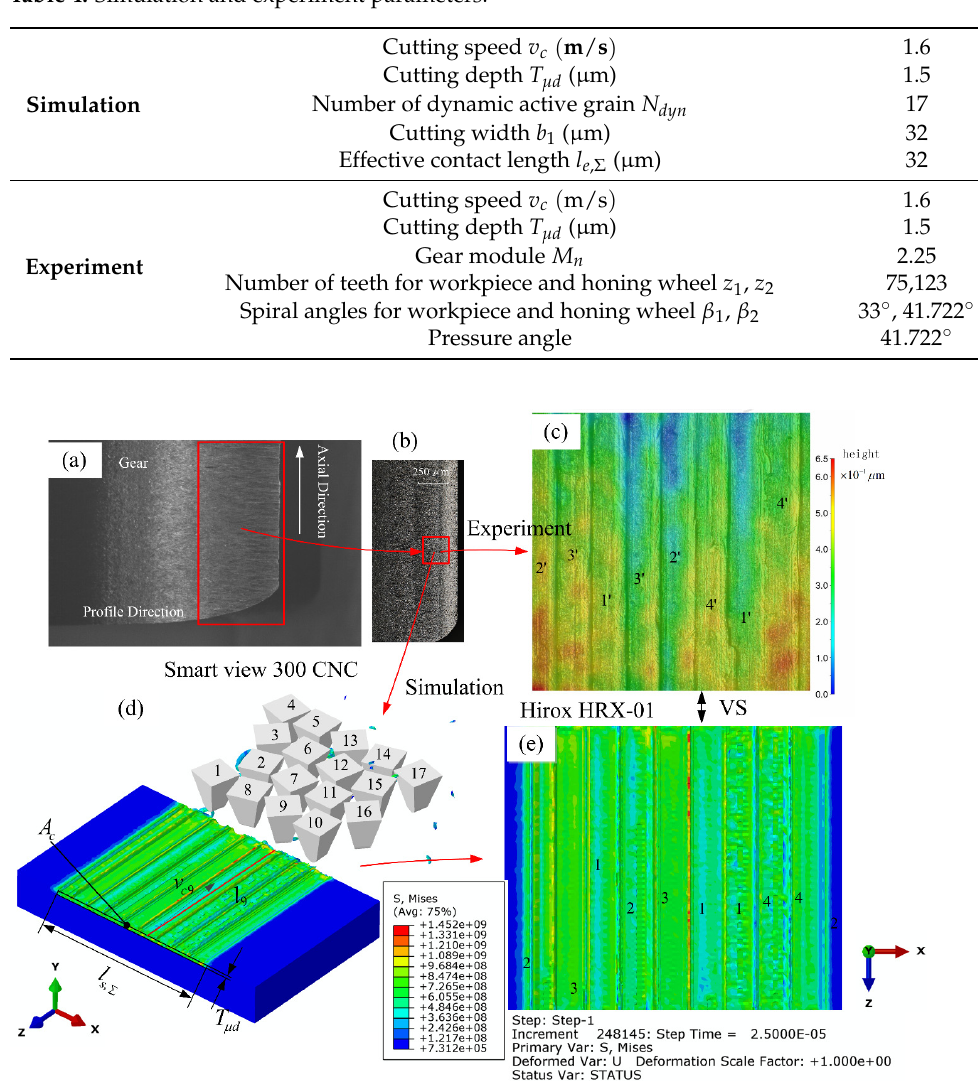
Figure 3. Comparison of simulation and experiment results of multi-grain honing process. ( a ) The micromorphology of the tooth surface of the workpiece under Smart View 300 CNC; ( b ) Micro- geometry of single-tooth local zoom under Hirox HRX-01; ( c ) A local enlarged view of the ( b ); ( d ) Finite element simulation results; ( e ) Top view of ( d ).